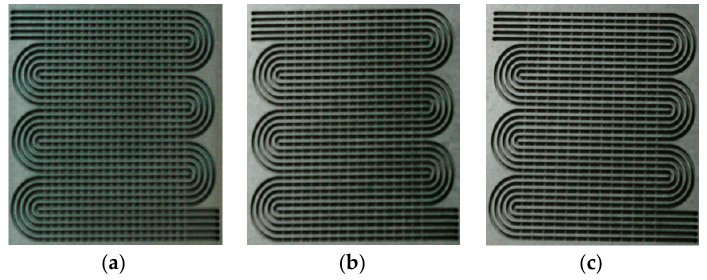
Figure 7. Bipolar plates of the gas flow cathode channels with the three wave form adhesive distances (ADs) of ( a ) AD 4.0, ( b ) AD 5.0, and ( c ) AD 6.0.